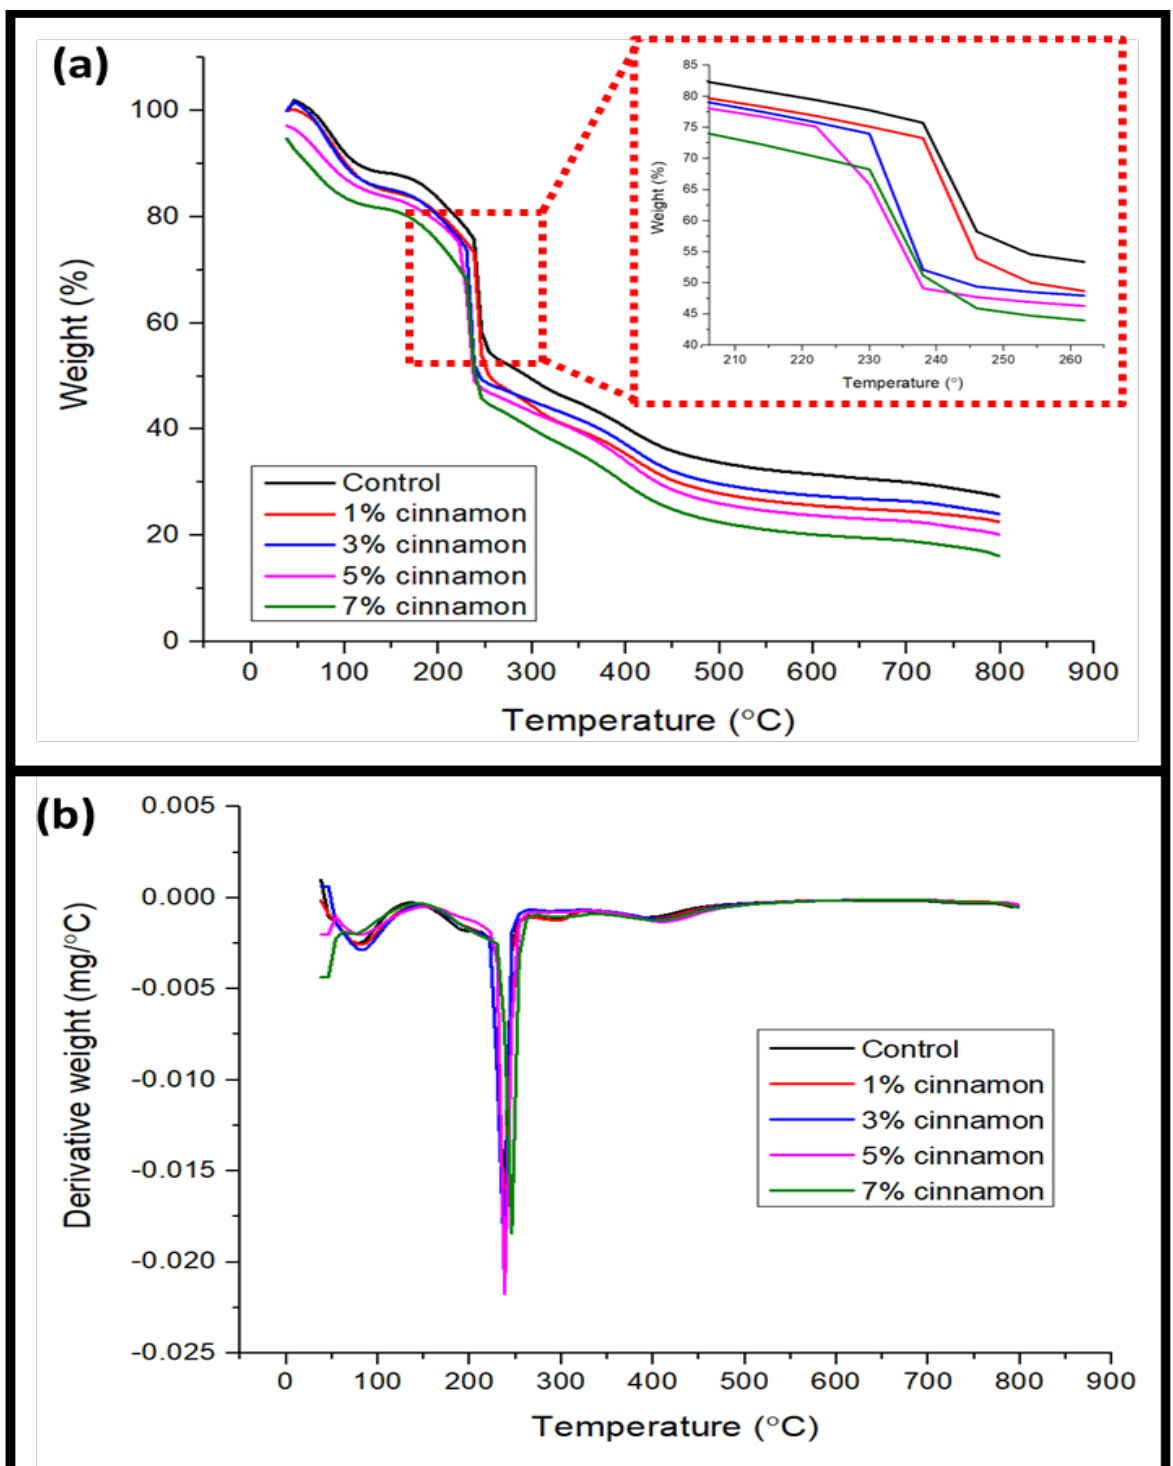
Figure 3. ( a ) TGA and ( b ) DTG curves of seaweed films incorporated with cinnamon nanoparticles.